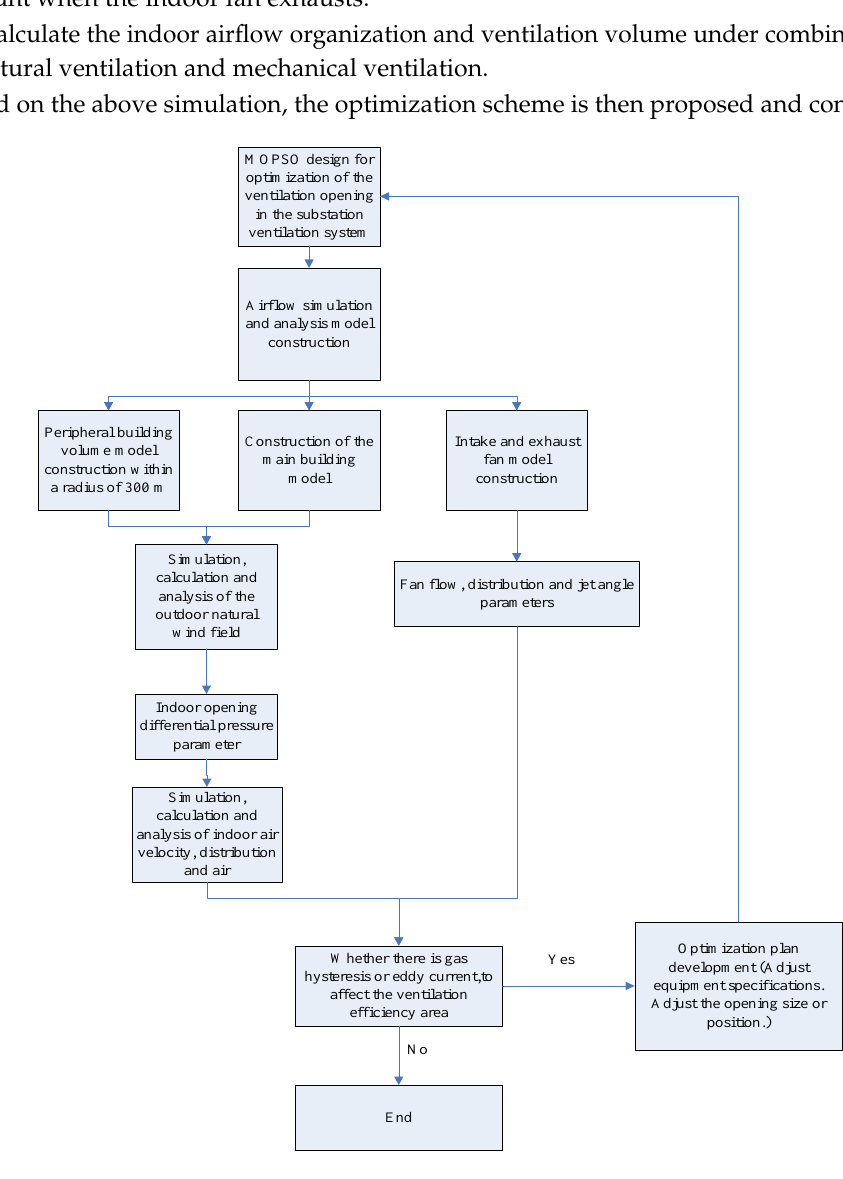
Figure 1. Flowchart of mixed ventilation simulation analysis and optimization design inside and outside the substation.